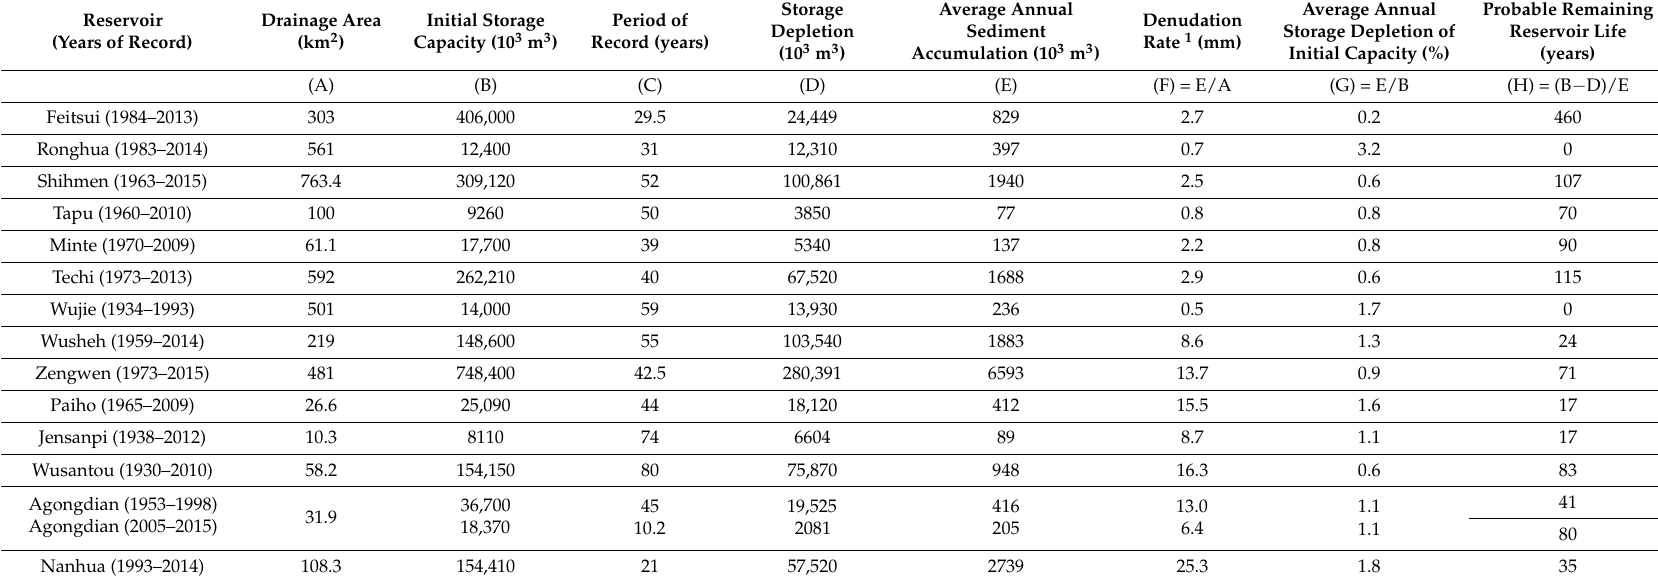
Table 2. Reservoir capacity sedimentation in Taiwan (data courtesy of Taiwan Water Resources Agency (WRA), Taipower Company, Taiwan Sugar Corporation, and Taiwan Water